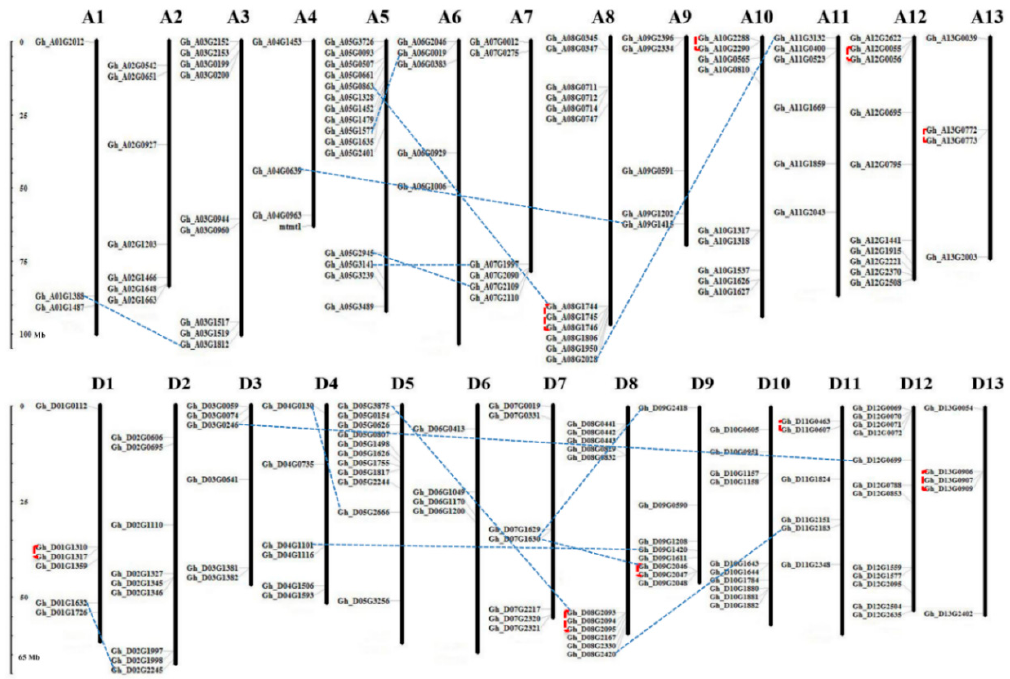
Figure 3. Chromosomal location and gene duplication events of 198 POD genes on 26 upland cotton chromosomes. Chromosome types and numbers are indicated at the top of each bar. The scale on the left is in mega-bases. The gene ID on the left side of each chromosome correspond to the approximate locations of each POD gene. The segmentally duplicated genes are connected by dashed blue lines, and the tandemly duplicated gene clusters are marked by red square bracket with dashed line.